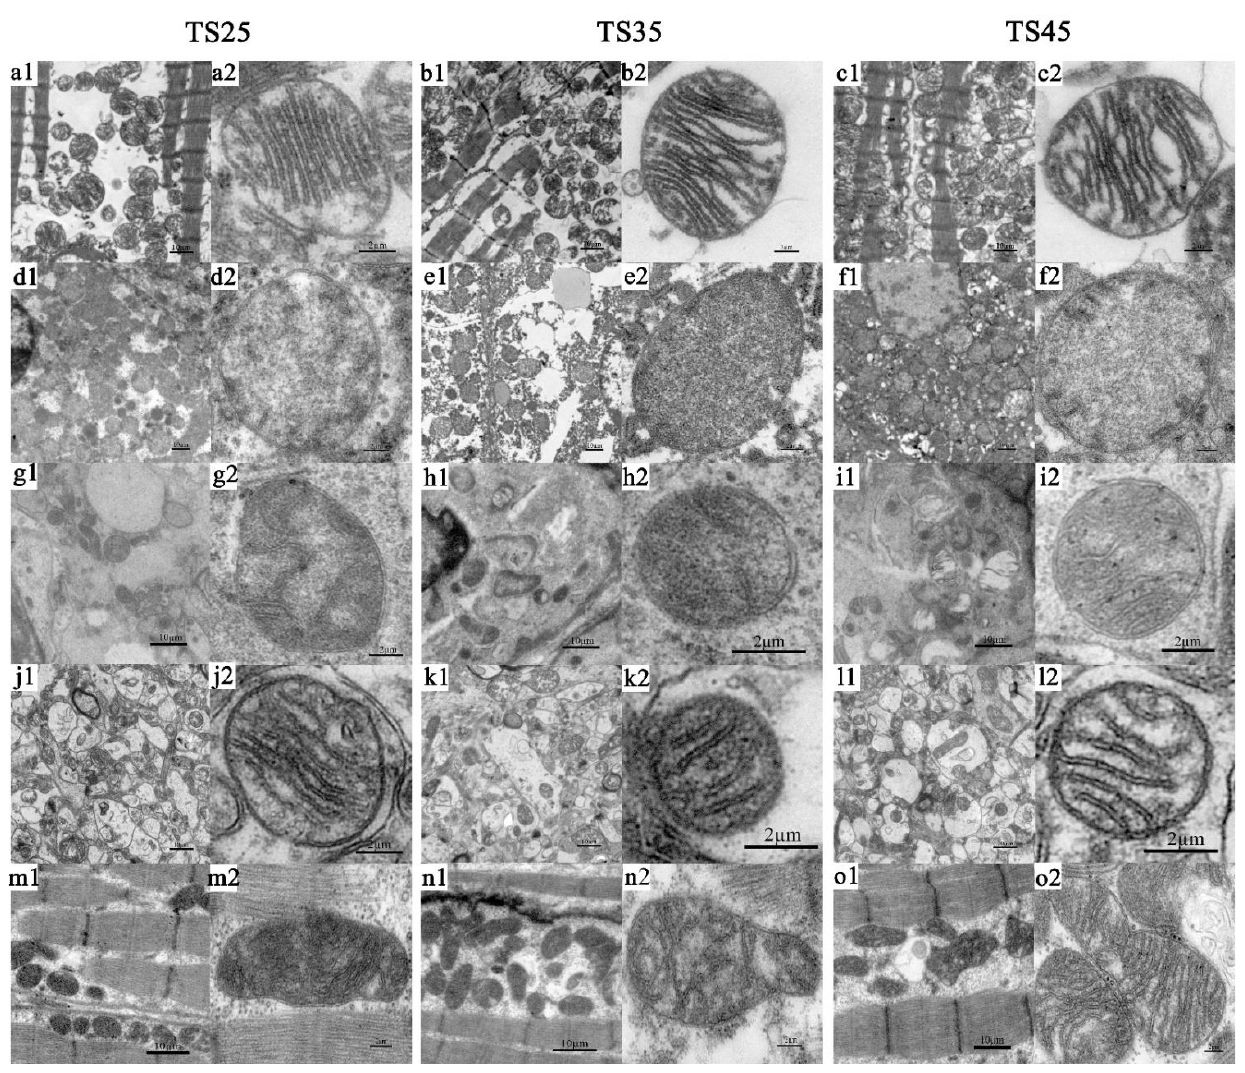
Figure 8. Representative electron micrographs of mitochondria in five tissues of Tibetan sheep. ( a – c ) Heart. ( d – f ) Liver. ( g – i ) Lung. ( j – l ) Brain. ( m – o ) Quadriceps femoris. ( a1 – o1 ) 2000×. ( a2 – o2 ) 10,000×. ( TS25 ) 2500 m altitude Tibetan sheep. ( TS35 ) 3500 m altitude Tibetan sheep. ( TS45 ) 4500 m altitude Tibetan sheep.